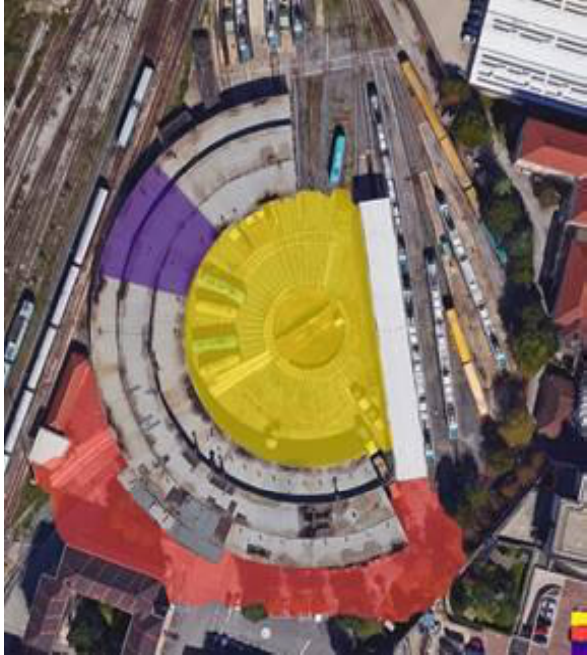
Figure 4. The thematic subdivision of the surveyed areas: in purple internal survey (TLS), in yellow external courtyard (TLS and SfM); in red topographic